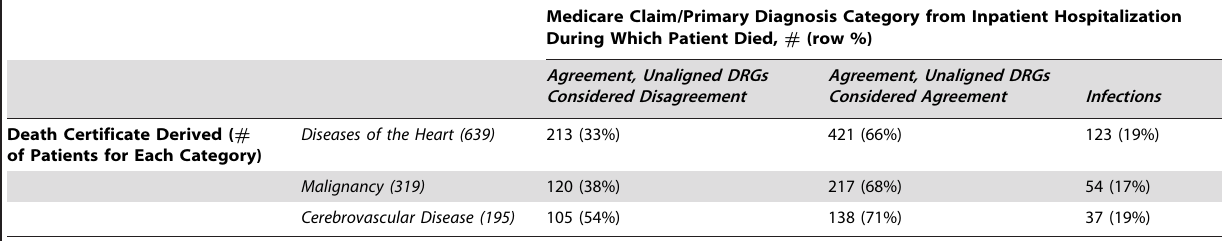
Table 2. Comparison of Cause of Death Agreement between DRGs and Death Certificates for Common Causes of